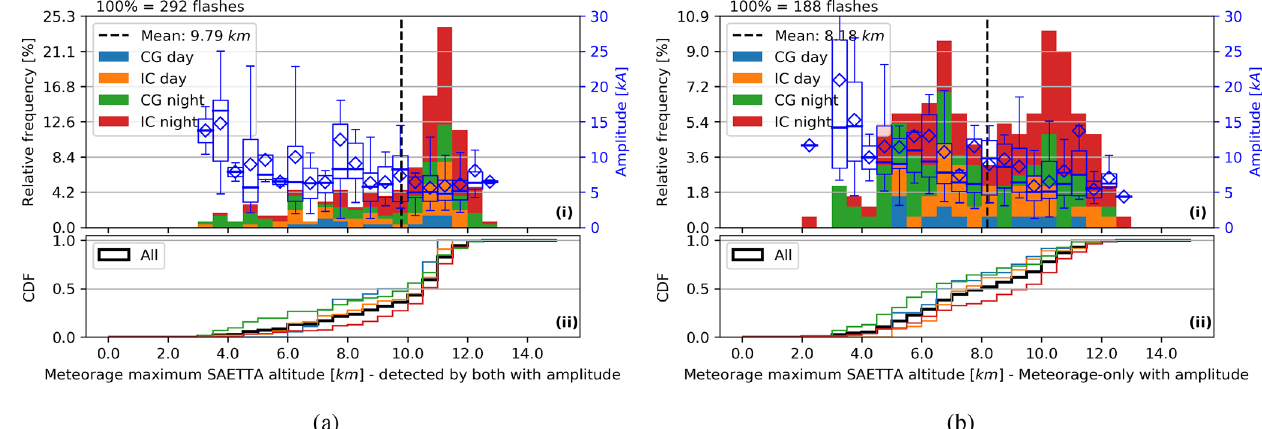
Figure 14. Flash maximum altitude of Meteorage flashes (from concurrent SAETTA observations) with (a) and without (b) a coincident ISS-LIS flash. Daytime, nighttime and flash type, IC and CG, are indicated by the colors. The histogram (i) and corresponding CDF (ii) use the same colors. The CDF additionally shows a black curve for all data. The histogram bin width equals 0.5km. The mean value is plotted as a dashed line. The total number of flashes is indicated above the histogram. The blue box plots (median as a line, mean as a diamond, IQR as a box, 1.5 IQR as whiskers; outliers not plotted) represent the distributions of the Meteorage mean absolute amplitude per flash for each altitude bin (scale fixed range from 0 to